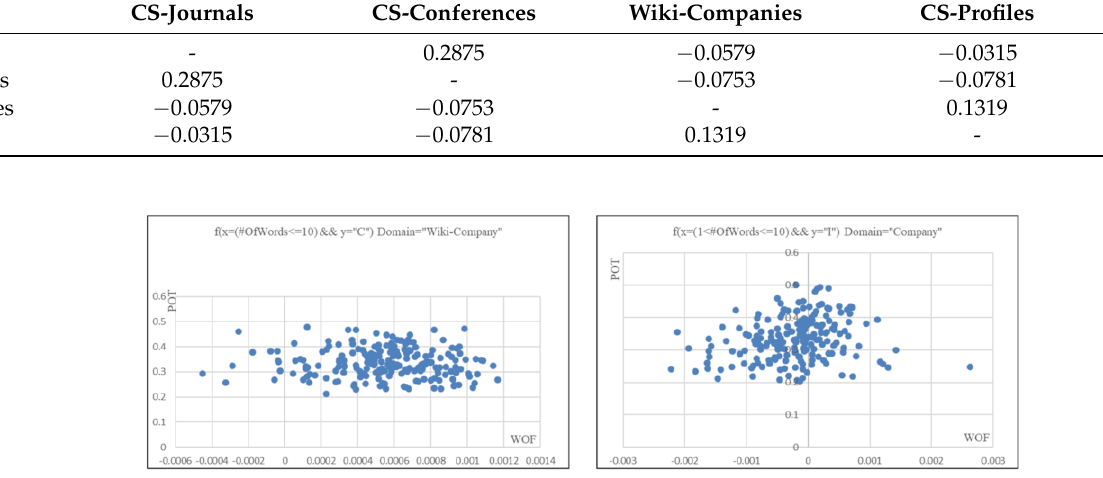
Table 3. The correlation coefficient matrix of the feature function f(x = (1 <# OfWords <= 10) && y = I). Domain